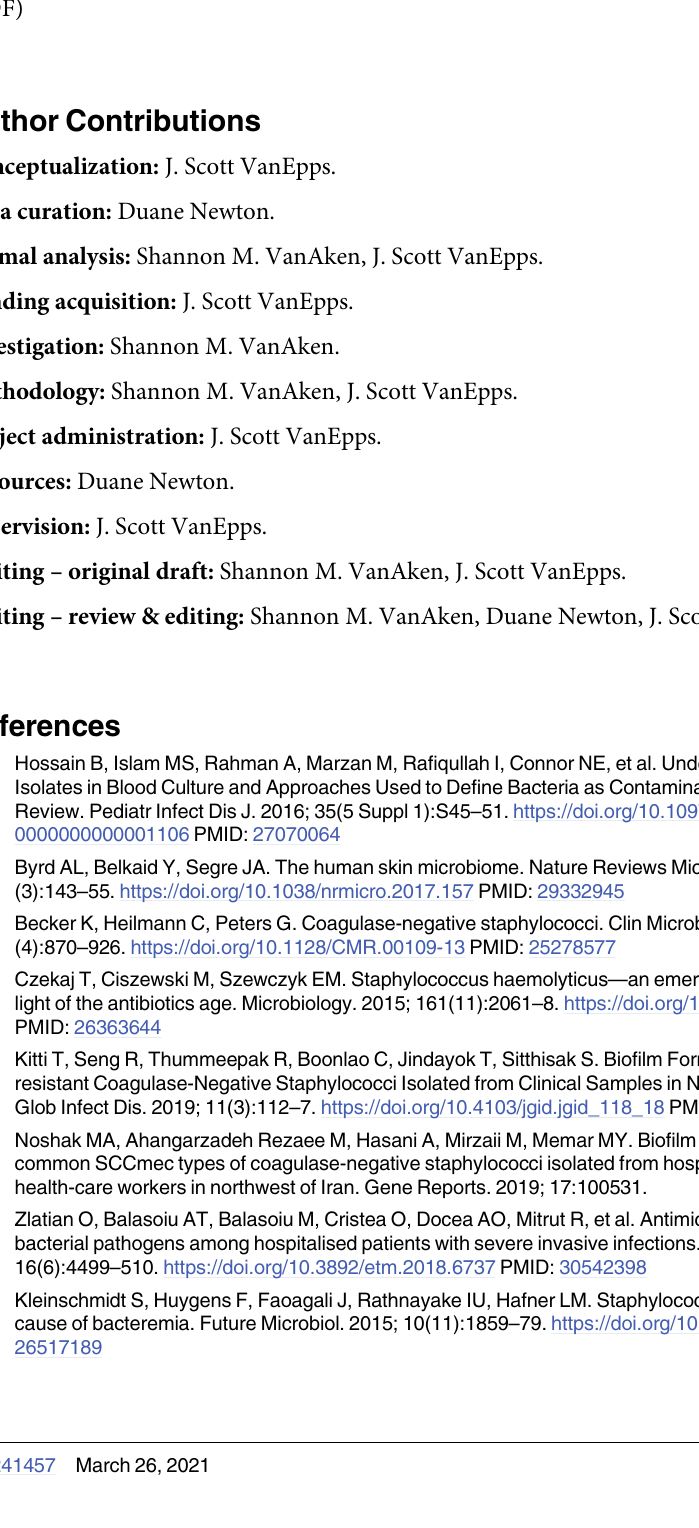
Fig OD vs CFUs; S3 Fig ANOSIM; S2 Table. PCR primers; S4 Fig Comparison of genotypic 600 vs phenotypic measures methicillin resistance. S1 Table. Dataset for predictive